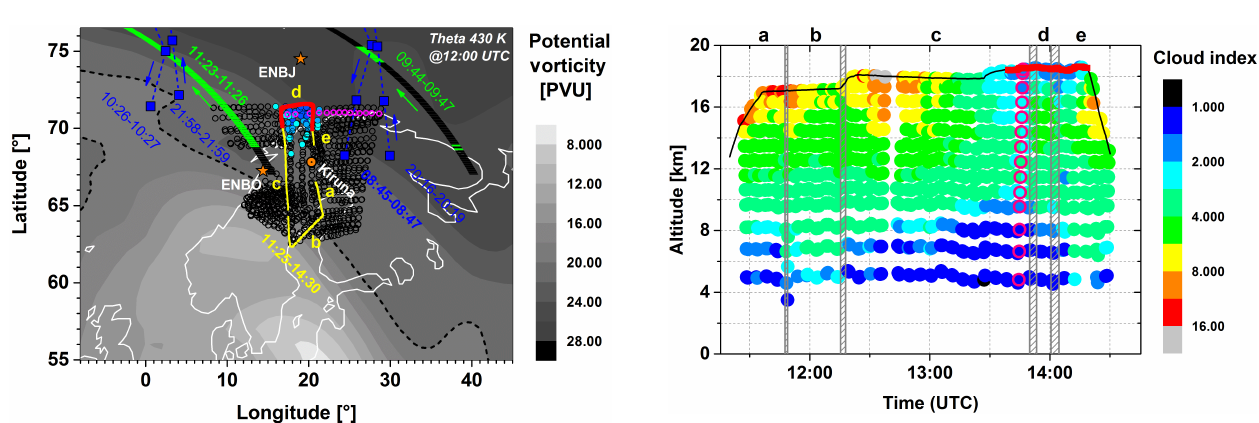
Figure 1. Flight path (yellow line) of the Geophysica and meteoro- logical situation during the PSC flight on 11 December 2011. Grey shading: ECMWF ERA-Interim potential vorticity at the potential temperature level of 430K. Black dashed line: polar vortex edge according to Nash et al. (1996). Open black circles: MIPAS-STR tangent points. Filled circles (cyan to blue): MIPAS-STR tangent points >16km with cloud index <3. Magenta circles: MIPAS-STR limb scan associated with spectra considered in radiative transfer simulations. Red line: flight section of FSSP-100 and CDP PSC ob- servations. Horizontal green/black bars: CALIPSO PSC observa- tions (green: PSC detected at 21km). Filled blue squares: MIPAS- Envisat observations at 18.4 to 19.0km exhibiting PSC signatures. Orange stars: radiosonde launch sites Bodø (ENBO) and Bjornoya (ENBJ).